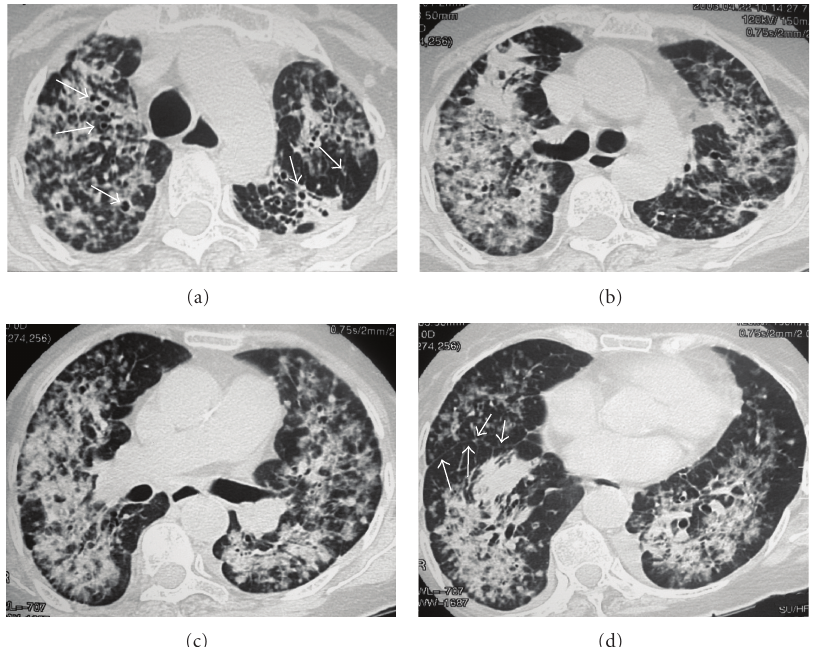
Figure 2: HRCT scans at four levels (a)–(d) demonstrate confluent airspace nodules and areas of consolidation in both lungs, with signs of architectural distortion that are characterized by bronchial dilatations within the lesions (white arrowheads in (a)) and fissure distortion with loss of the regularity (white small arrows in